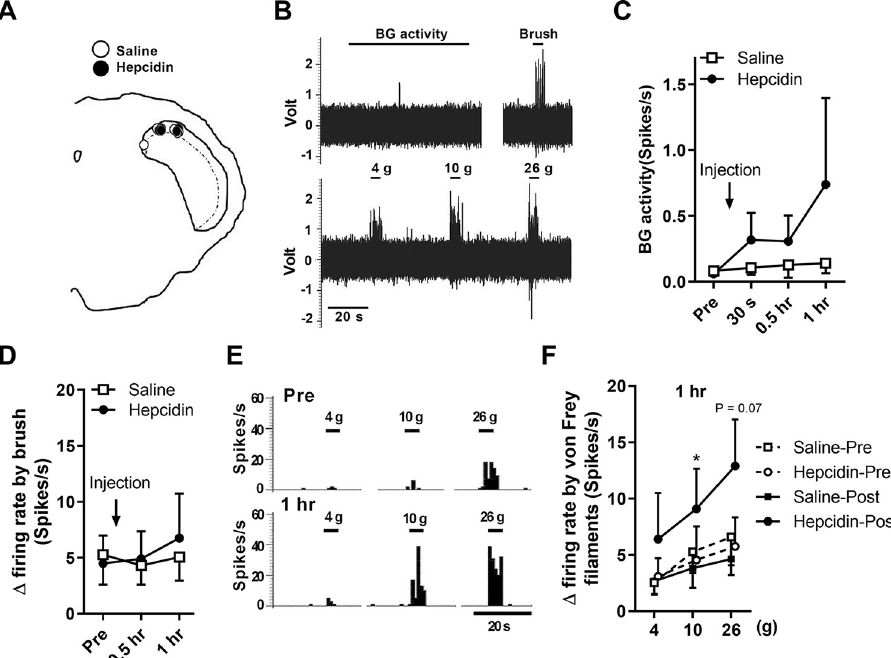
Fig 6. The effects of hepcidin on responses of wide dynamic range (WDR) neurons innervated the oral mucosa in the labial fornix region of the inferior incisors in lamina I of the trigeminal spinal subnucleus interpolaris/ caudalis (Vi/Vc). Error bars indicate SEM. (A) Recording sites are located at obex in Vi/Vc. Open circle: Saline, Closed circle: Hepcidin. (B) The raw traces of WDR neurons responses and the frequency of WDR neuronal spikes in response to mechanical stimuli by brush and von Frey filament in naive rats. (C) Mean background (BG) activity of WDR neurons for 60 s before and 30 s, 0.5, and 1 hour after saline or hepcidin injections to the oral mucosa (n = 5 in each group). (D) Mean Δ firing rate of WDR neurons in response to mechanical stimulation using a brush to the oral mucosal region before (pre) 0.5 and 1 hour after saline or hepcidin injections to the oral mucosa (n = 5 in each group). (E) Representative example of neuronal activity in response to mechanical stimulation using von Frey filaments to the oral mucosal region before (pre) and 1 hour after saline or hepcidin injections to the oral mucosa. (F) Mean Δ firing rate of WDR neurons in response to mechanical stimulation using von Frey filaments to the oral mucosal region 1 hour after saline or hepcidin injections to the oral mucosa (n = 5 cells in each group). * p < 0.05 vs. hepcidin pre, Paired